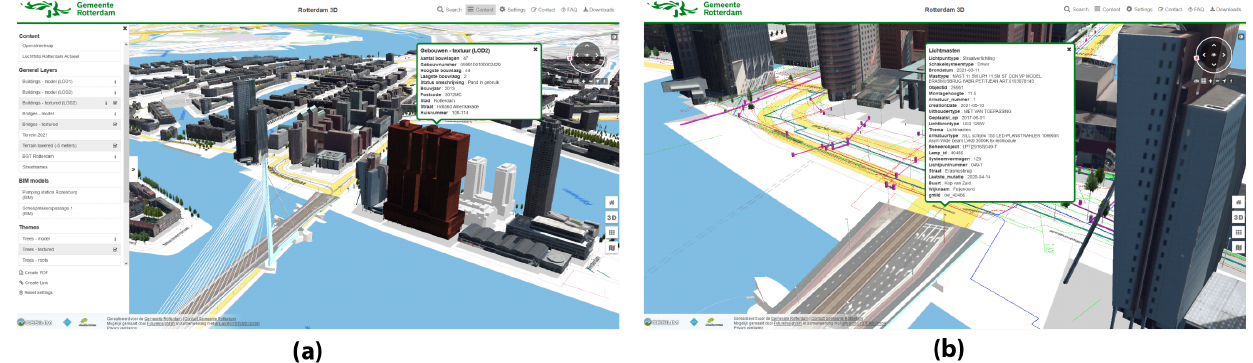
Figure 6. The Rotterdam 3D city model—a digital twin: ( a ) Detail of 3D city model application with building information. ( b ) The layer of city infrastructure with public lamp details